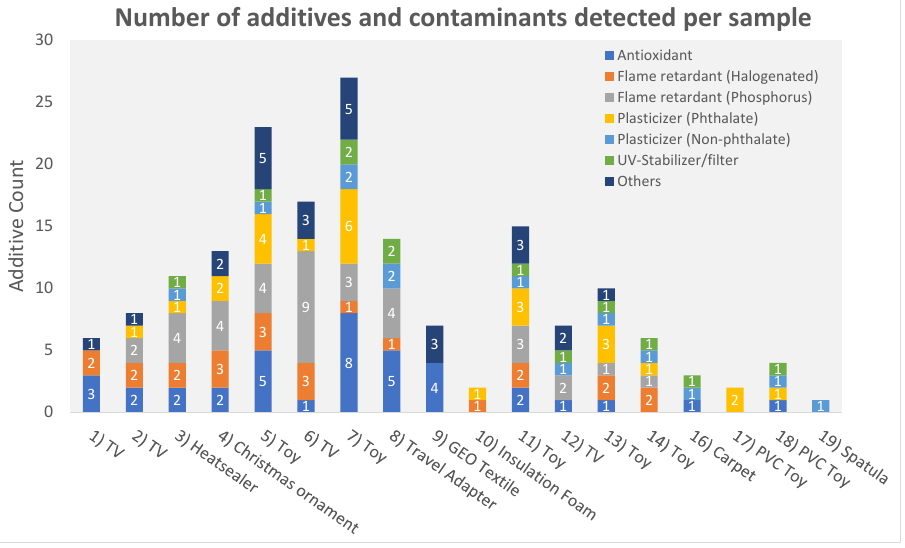
Figure 3. Number and type of additives and contaminants identified per sample. Sample 15 (PVC CRM) is not included in this figure because it is not a consumer product.